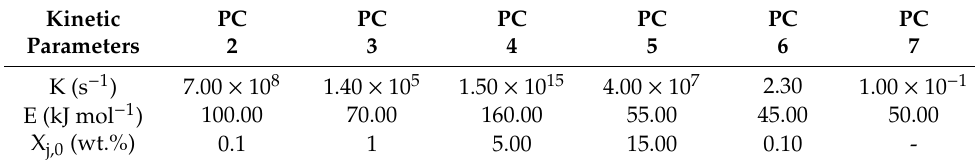
Table 5. Lower bonds of the pseudocomponents (PC).